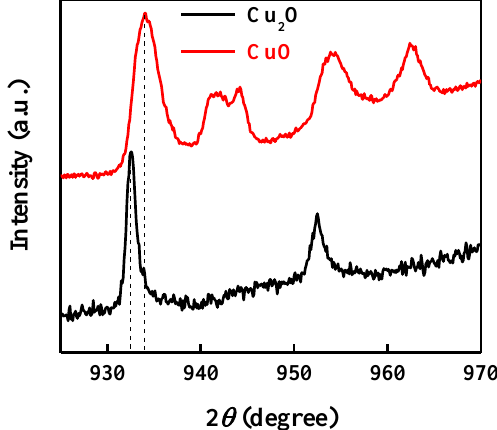
Figure 2. Cu2p XPS spectra of the bottom layer of CuO and the top layer of Cu 2 O.